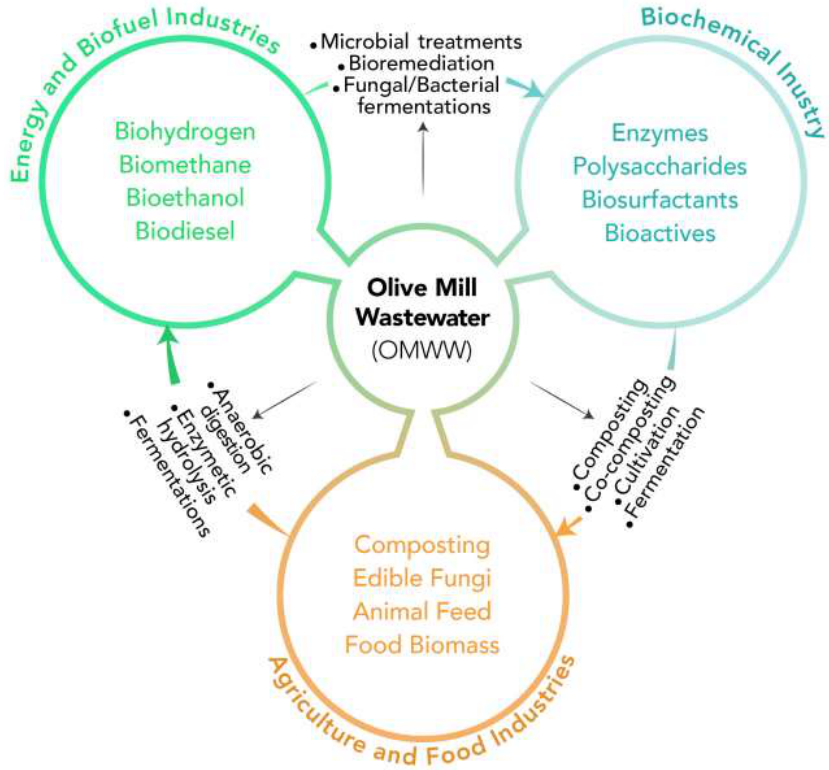
Figure 6. Microbial valorization and potential uses of OMW